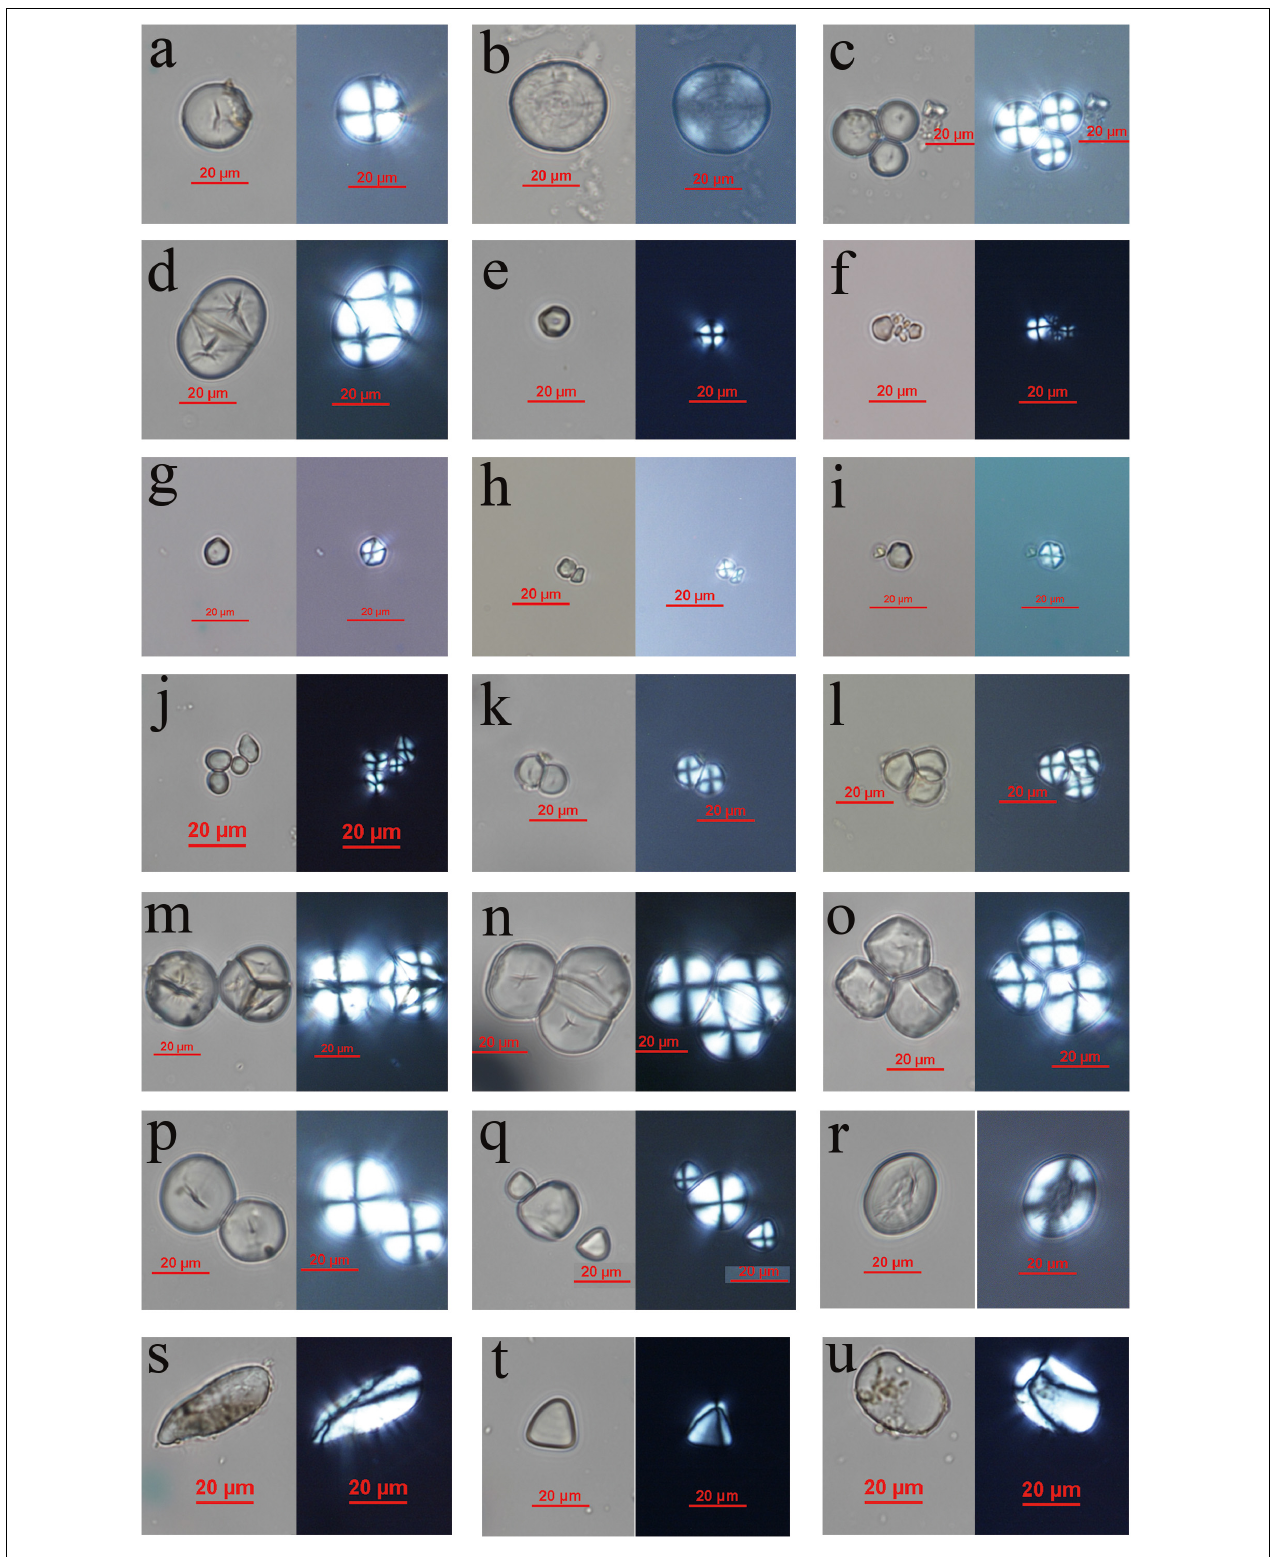
FIGURE 5 | Starch granules from Level III Liangwangcheng dental residue samples. ( a,j,m,s,u : starch granule from M125; b,r : starch granule from M121; c : starch granule from M127; d,h,k,l,n,p,q : starch granule from M147; e : starch granule from M226; f : starch granule from M129; g,i : starch granule from M144; o : starch granule from M251; t : starch granule from